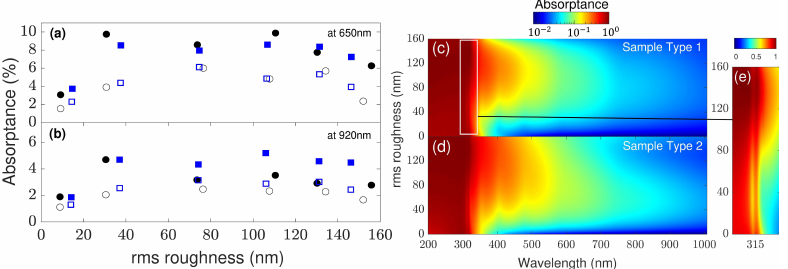
Figure 5. Absorptance as a function of rms roughness of surfaces for sample type 1 (Ag, filled black symbols) and sample type 2 (ZnO/Ag, empty black symbols) at incident wavelengths of ( a ) 650 nm and ( b ) 920 nm, respectively. The corresponding experimental data points extracted from Ref. [28] are shown in blue. ( c , d ) Absorptance on a logarithmic scale as a function of rms roughness and wavelength for the two sample types using a third-order polynomial fitting curve. ( e ) The plasmon peak of silver is observed around 315 nm. Here, a linear scale was used for